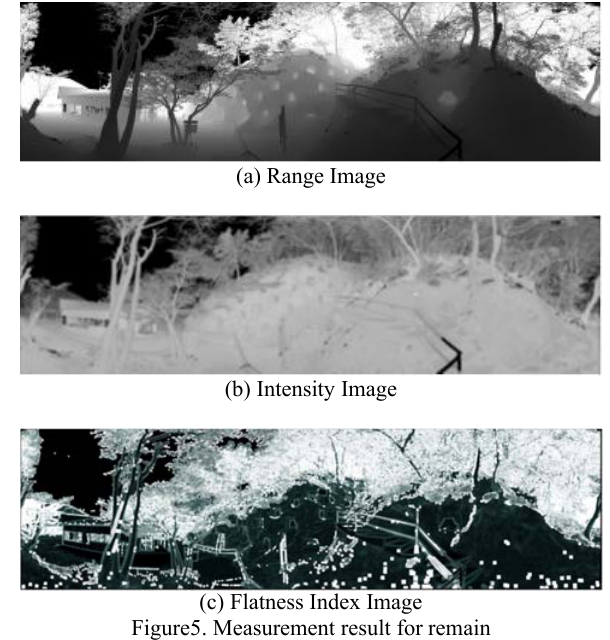
Figure5. Measurement result for remain